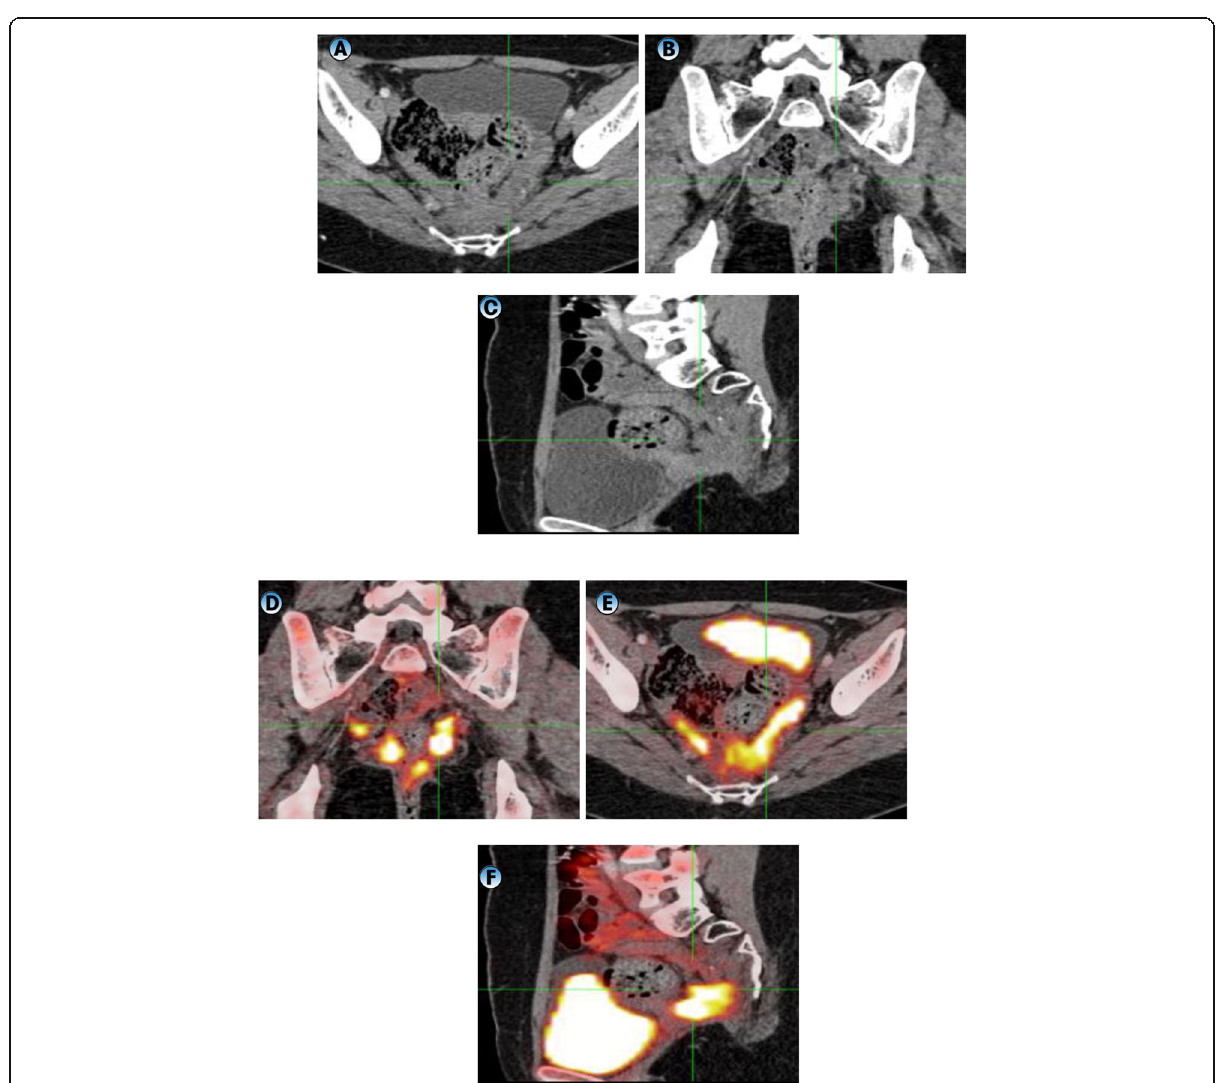
Fig. 1 A 36-year-old female patient with given history of treated cancer rectum 3 years ago (surgery, chemo and radiotherapy). Recent follow-up CT showed progression of pre-sacral soft tissue sheet and mild recto-sigmoid mural thickening, the patient came for PET/CT assessment. a – c Axial, coronal, and sagittal CT images of the pelvis showed pre-sacral soft tissue thickening extending to the terminal part of the colon which itself demonstrates circumferential thickening. d – f Axial, coronal, and sagittal fused PET/CT images of the pelvis. PET/CT showed increased FDG uptake with SUVmax 16.4 corresponding to this soft tissue thickening and proved to be local tumor